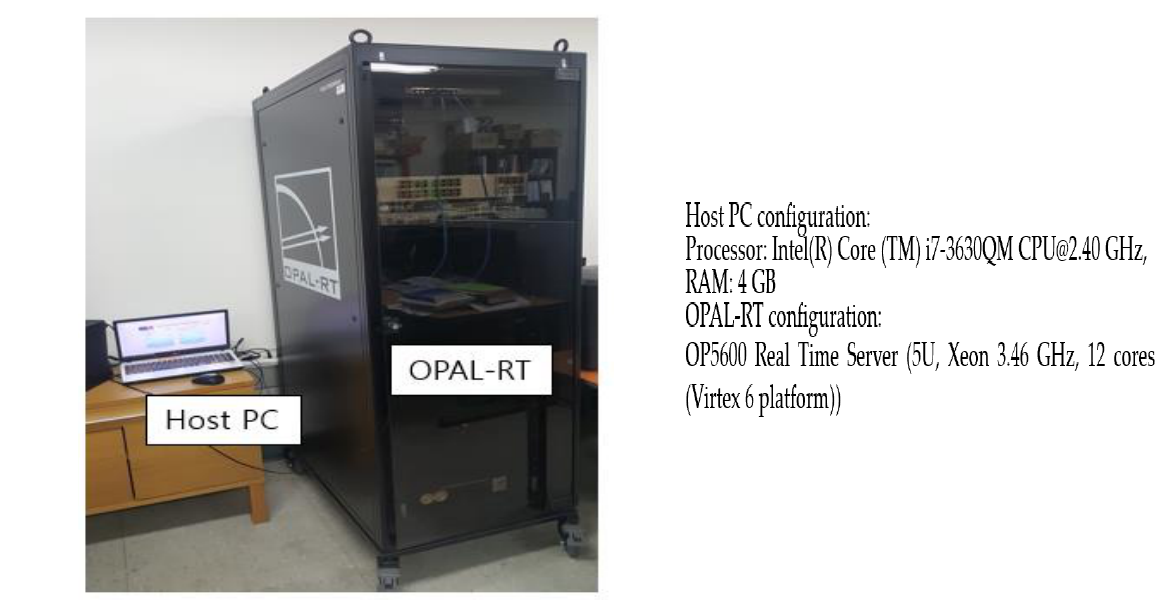
Table 2. Search space boundary values for gain